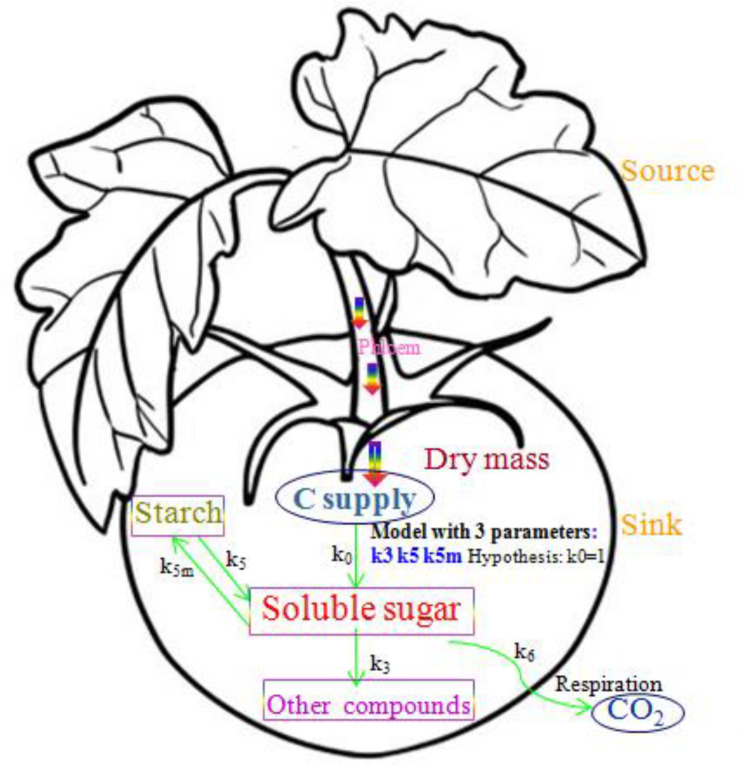
A schematic of the simplified SUGAR model showing sugar metabolism and carbon balance in the tomato fruit. Arrows represent carbon flows. The parameters k3(t), k5(t), and k5m(t) are the relative rates of carbon conversion for soluble sugars, starch, and other carbon compounds. Rectangles identify the three major types of carbon compounds in the fruit, and the two ellipses show carbon supply and loss through respiration.